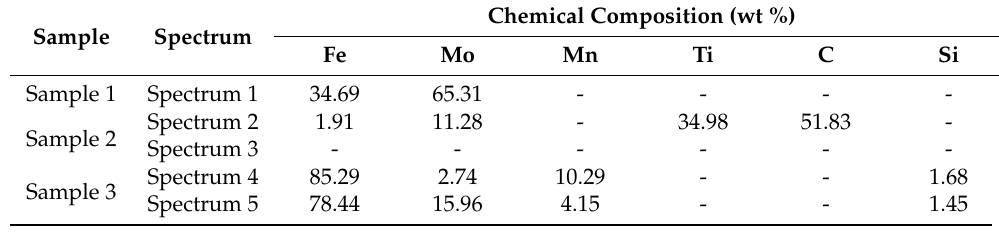
Table 6. Results of the EDS analysis at the local areas from Figure 9.